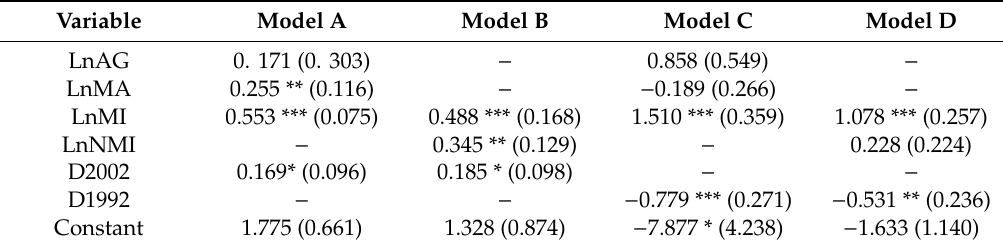
Table 6. Long − run elasticities of economic growth between 1980–2017 (ARDL).